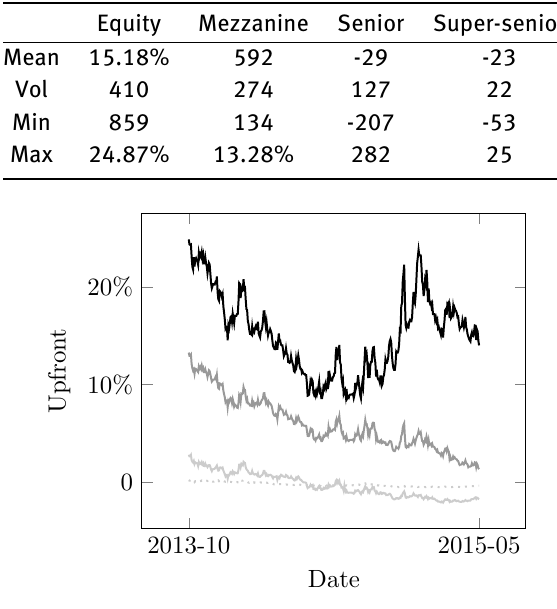
Figure 7: CDX.NA.IG.21 upfront values in percents over the sample period. Figure 7 displays the upfronts for the equity (black), mezzanine (grey), senior (light-grey) and super-senior (dotted light-grey)